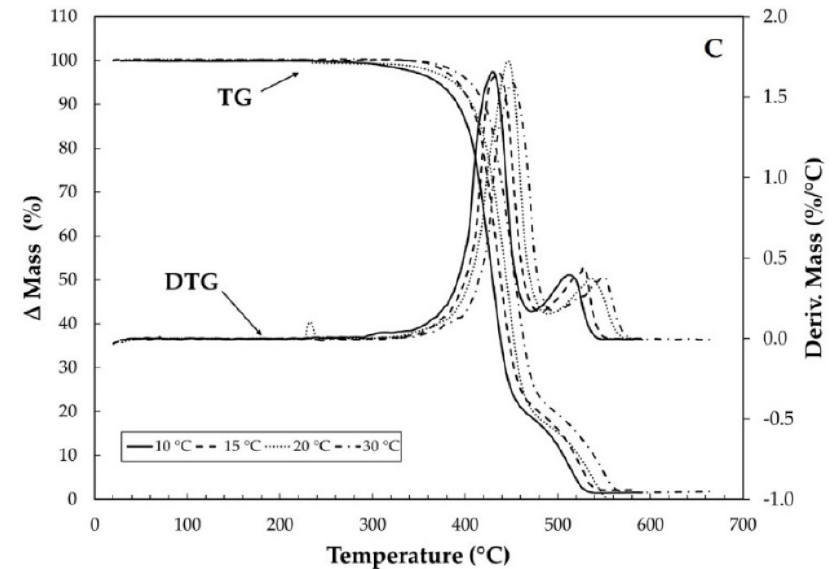
Figure 7. TG/DTG curves of virgin PET ( A ), PET 500 h ( B ), and PET 1000 h ( C ) with heating rates of 10, 15, 20, and 30 °C·min − 1 under synthetic air gas purge with flow of 100 mL min − 1 in α -alumina crucible.